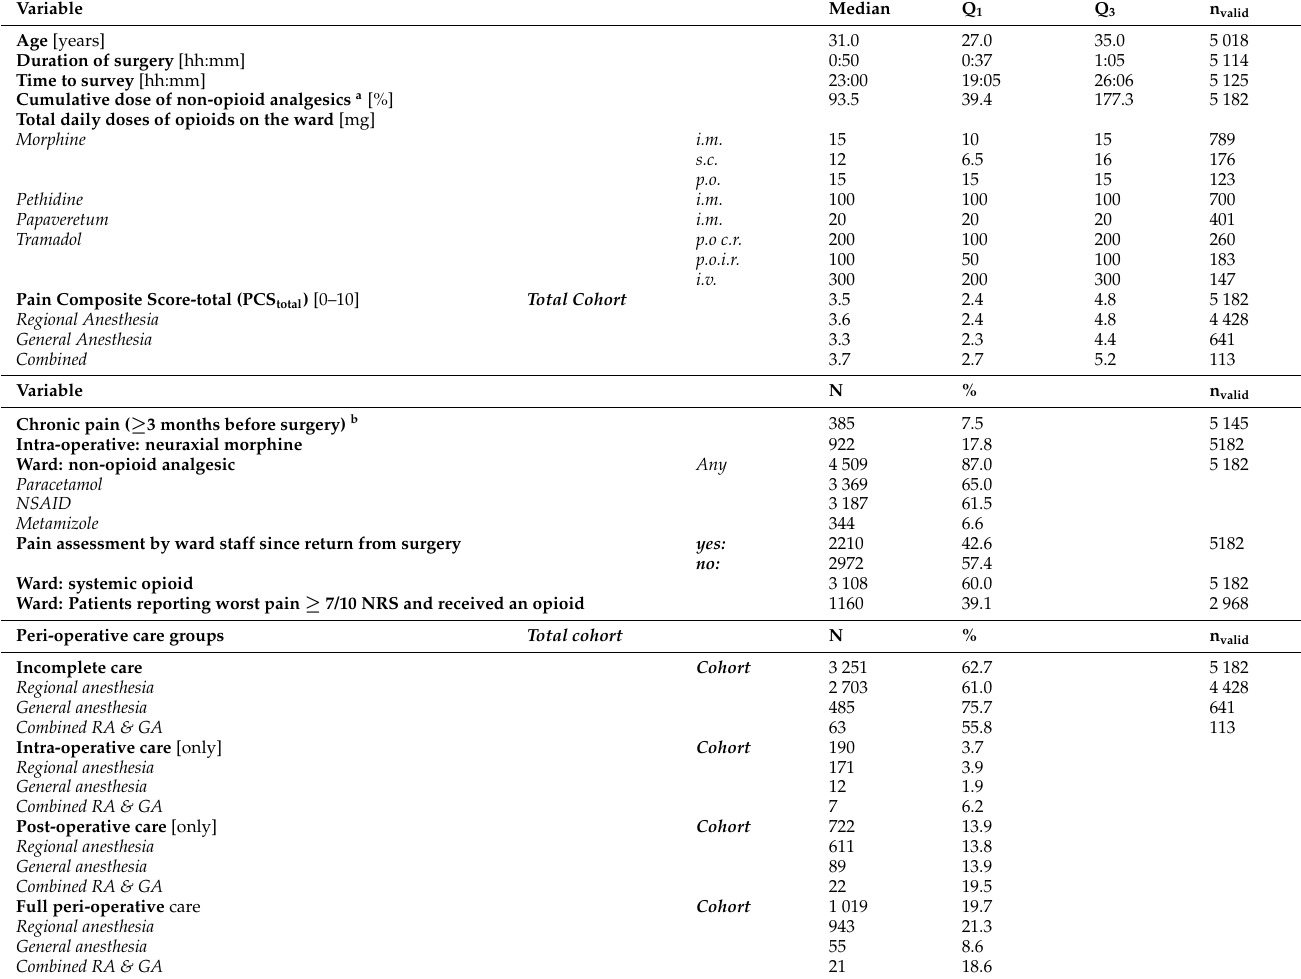
Table 1. Descriptive statistics of the cohort for continuous, dichotomous, and categorical